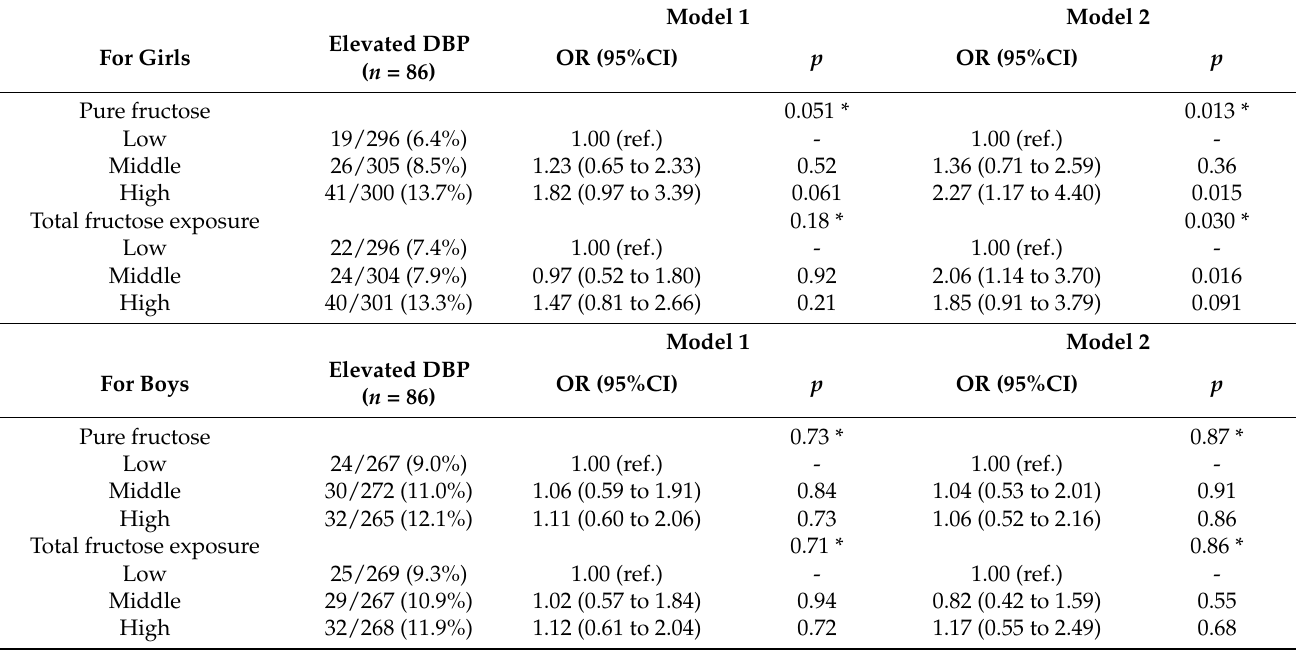
Table 7. Association between elevated diastolic blood pressure with pure and total fructose exposure from non-natural